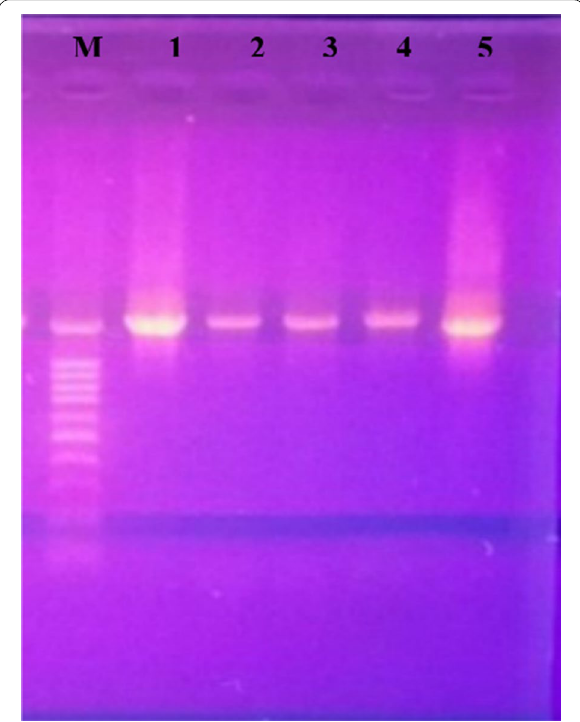
Fig. 3 Agarose gel analysis of PCR products from amplification of 16S rDNA of five bacterial strains. Lane M: represents the molecular size marker (1 kb leader). Lane 1: represents Paenibacillus lactis AFC1 (MG991563), Lane 2: represents Lysinibacillus fusiformis AFC2 (MG991566), Lane 3: represents Stenotrophomonas maltophilia AFC3 (MG991565), Lane 4: represents Lysinibacillus macrolides AFC4 (MG991564) and Lane 5: represents Bacillus cereus AFC5 (MG991567)